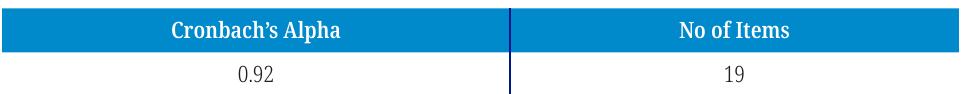
Table 3. Cronbach’s